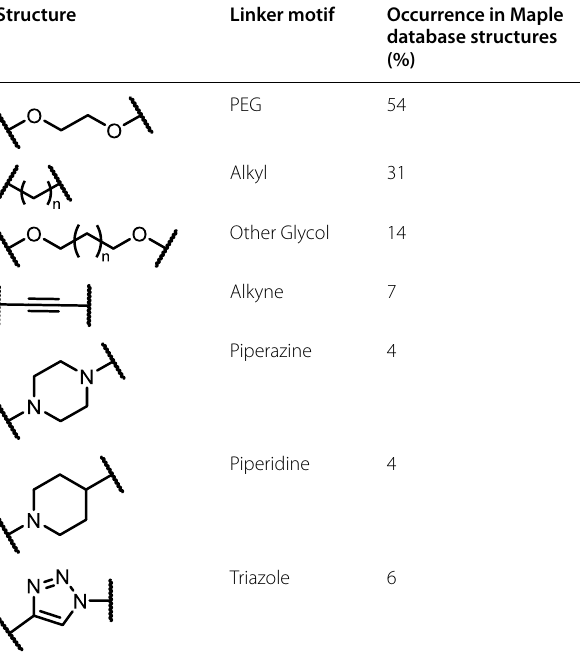
Table 5 Occurrence of selected linker motifs in the Maple database of published PROTACs structures [81] Structure Linker